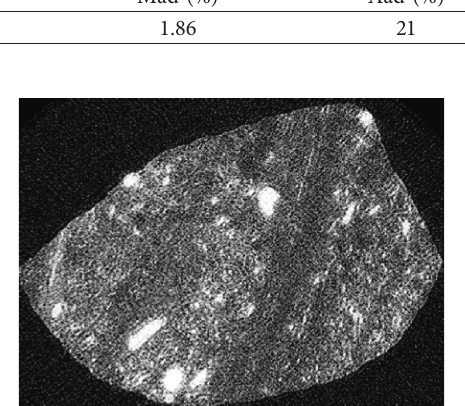
Figure 3: 2D section of the 556 th slice of the lignite specimen at room